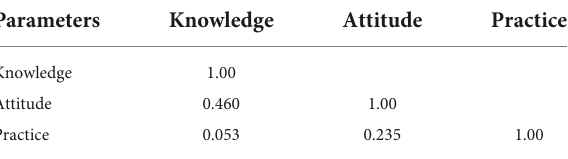
TABLE 7 Results of the convergent validity of the CKD-KAP